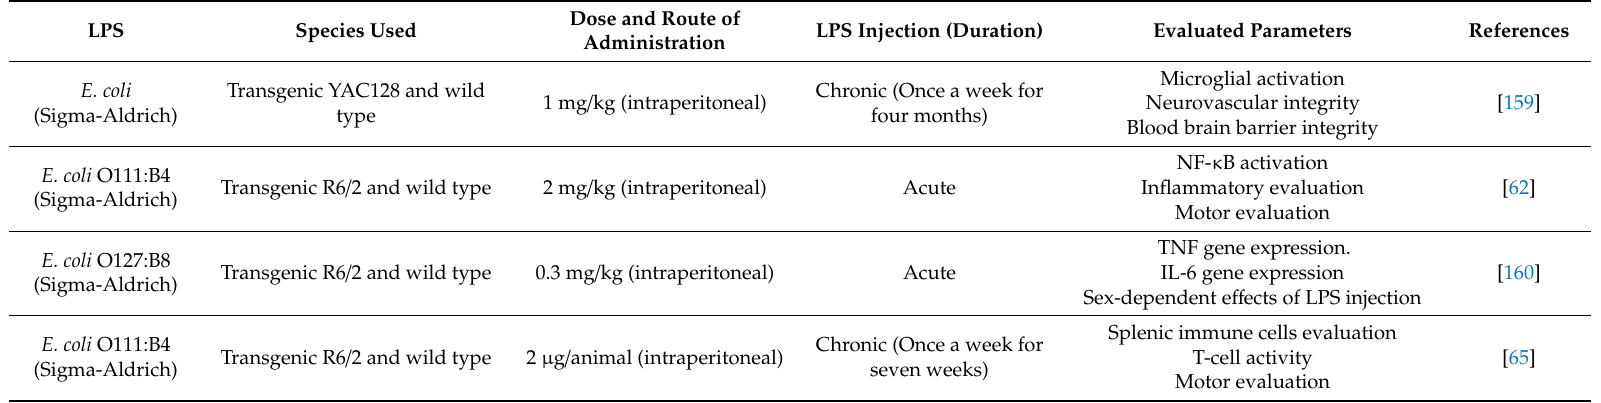
Table 6. LPS source, species used, dose and route of administration, duration, evaluated parameters of models of systemic LPS challenges for the elucidation of Huntington’s disease